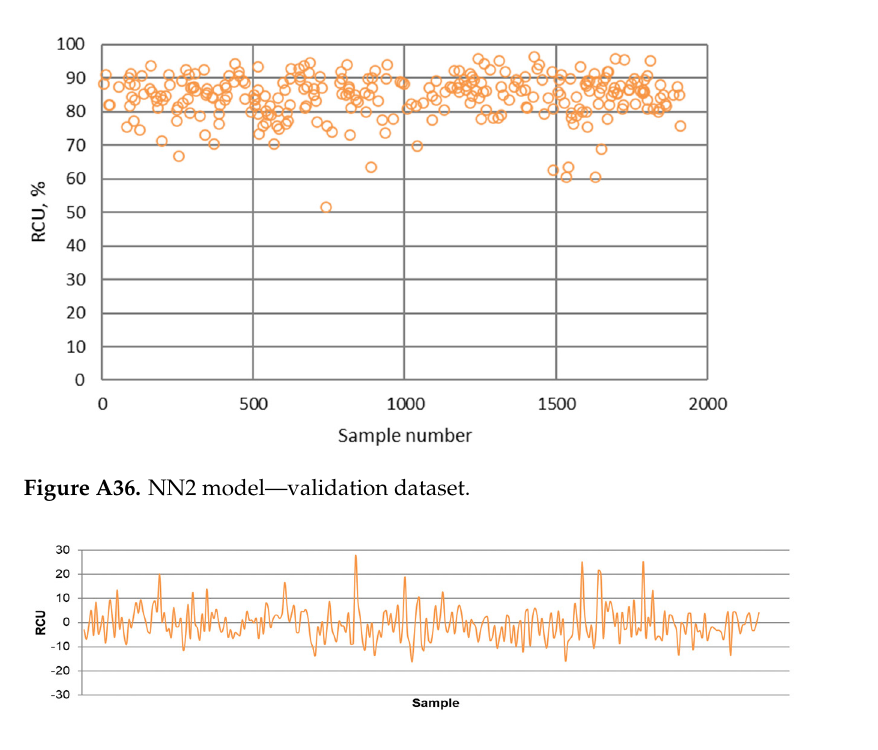
Figure A37. Prediction error of NN2 model validation dataset. Table A4. Regression statistics parameters of NN1 model datasets.